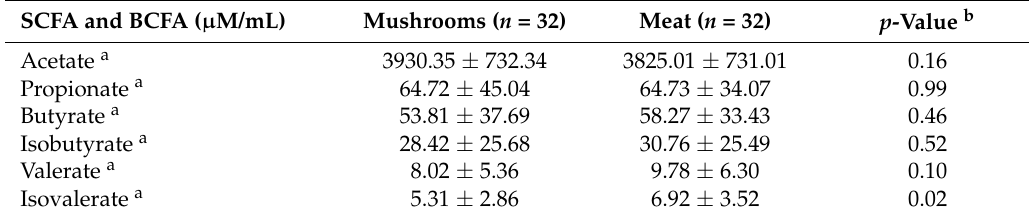
Table 8. Fecal short chain fatty acids (SCFA) and branched chain fatty acids (BCFA) produced on mushroom and meat diets.